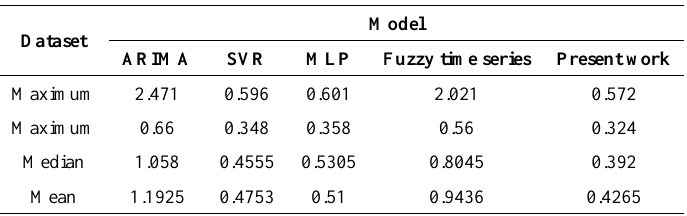
Table 2. MASE Criterion